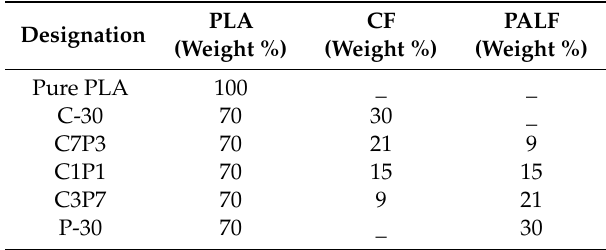
Table 3. Formulation of CF / PALF / PLA